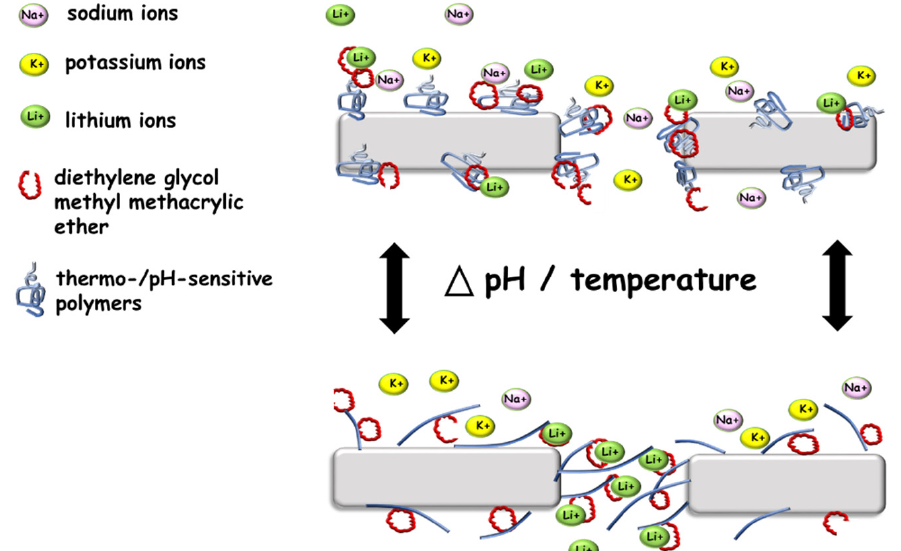
Figure 4. Scheme of the ion channel based on smart polymers.